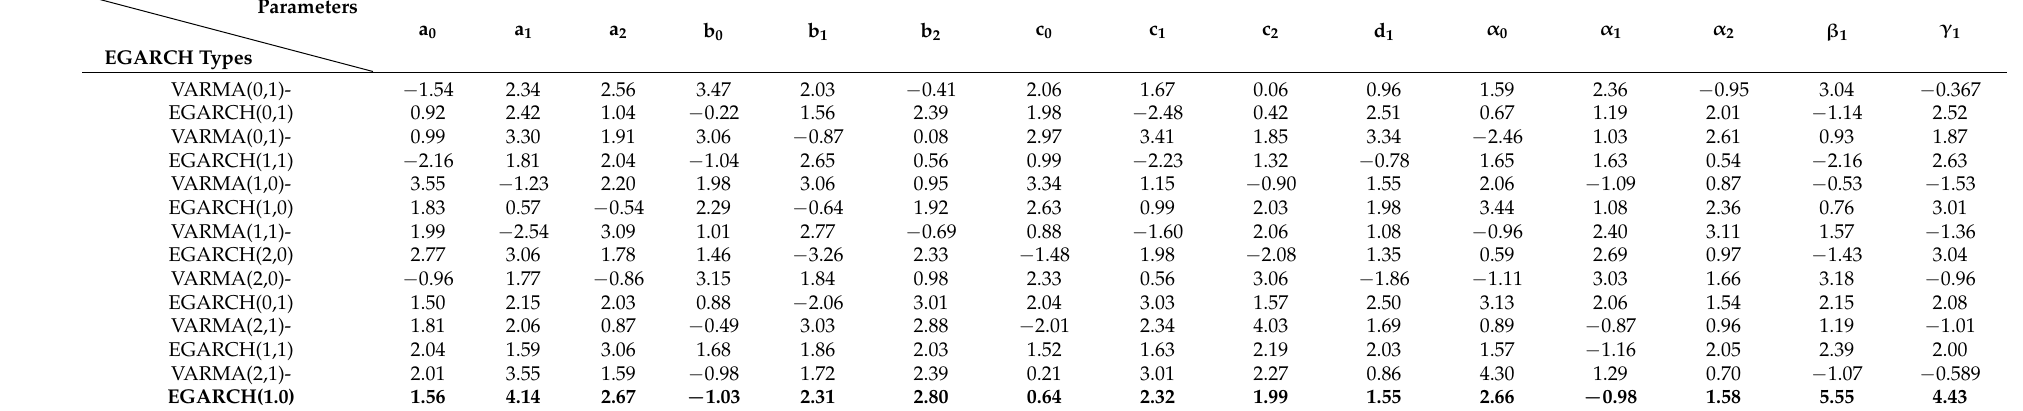
Table 5. Parameters of VARMA(p,q)-EGARCH (p,q) for mobile pollution